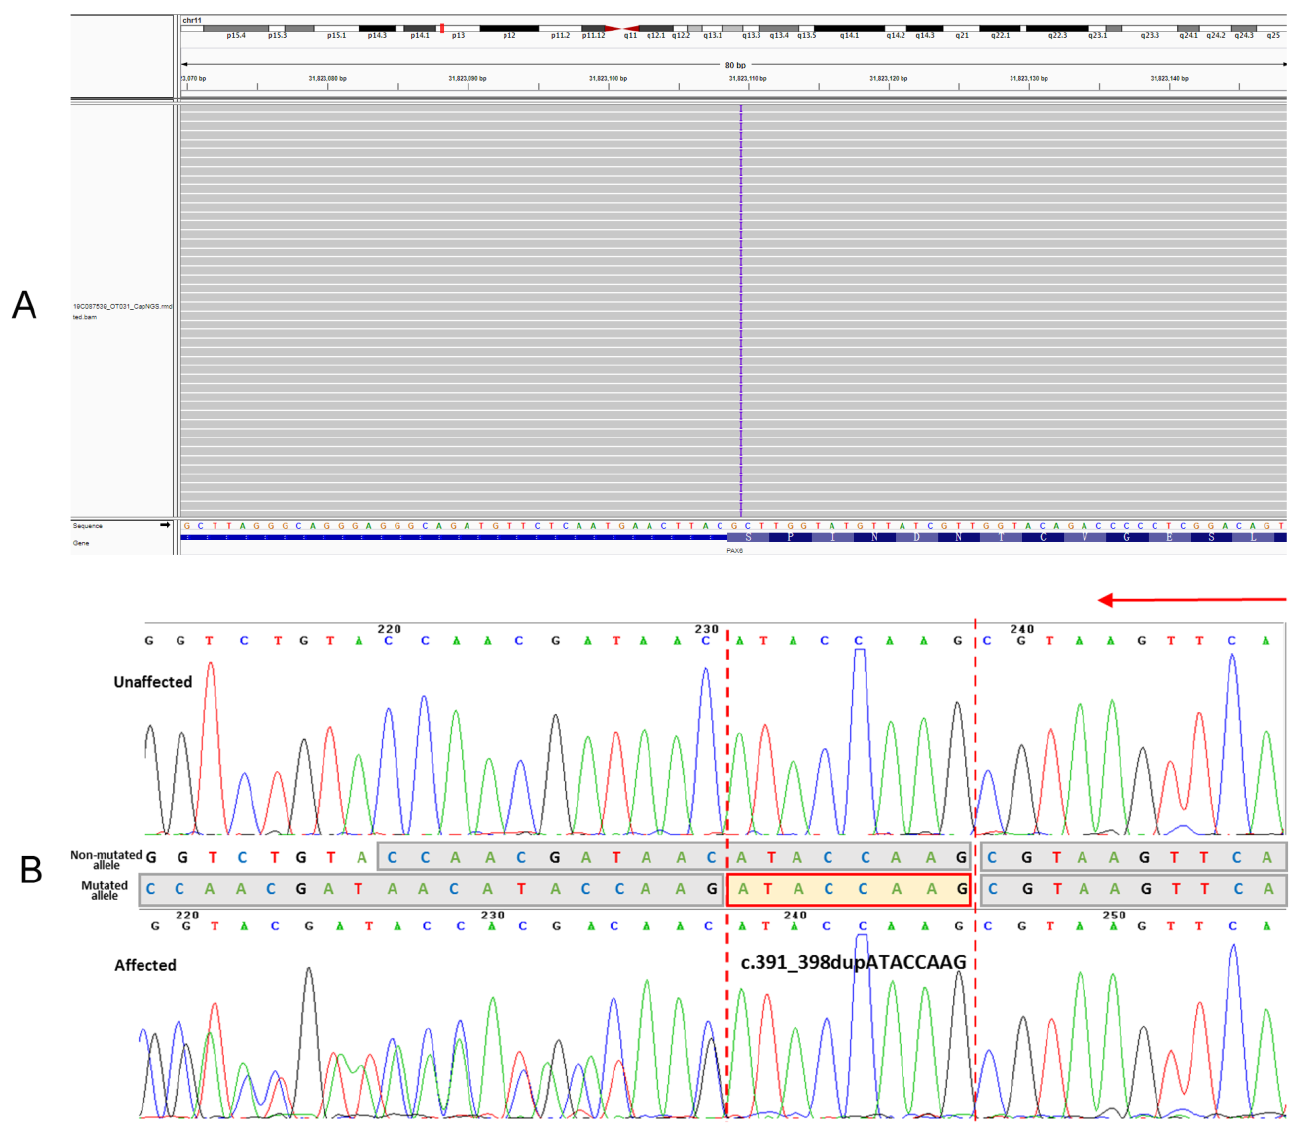
Figure 3. Sequencing results for the variant c.391_398dupATACCAAG of the PAX6 gene. ( A ) Integrative genomics viewer visualization of whole-exome sequencing showing a novel heterozygous variant in the PAX6 gene in the proband (IV8). ( B ) Sanger sequencing results of the PAX6 gene confirmed the mutant allele with ATACCAAG duplicated at the position indicating by two red dotted line, in the affected individuals represented in the lower panel versus the normal individuals in the upper panel. Sequencing direction is indicated by an red arrow. The PAX6 gene variant (c.391_398dupATACCAAG, p.Ser133Argfs*8) was located in exon 7. This 8-bp duplication converts serine to arginine at amino-acid position 133, fol-